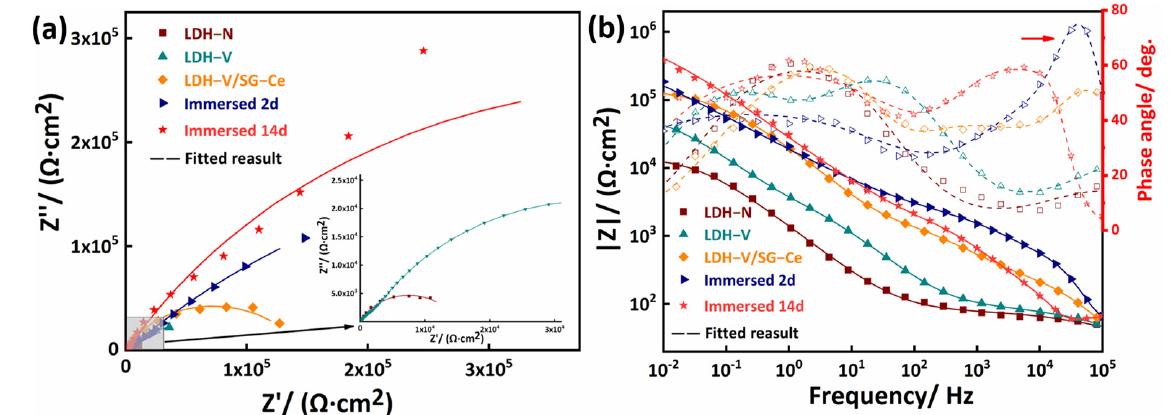
Figure 5. ( a ) Nyquist plots and ( b ) Bode plots of LDH and LDH/SG samples exposed in 3.5 wt.% NaCl solution for 2 days and 14 days (gray part in ( a ) is a partial enlargement) .